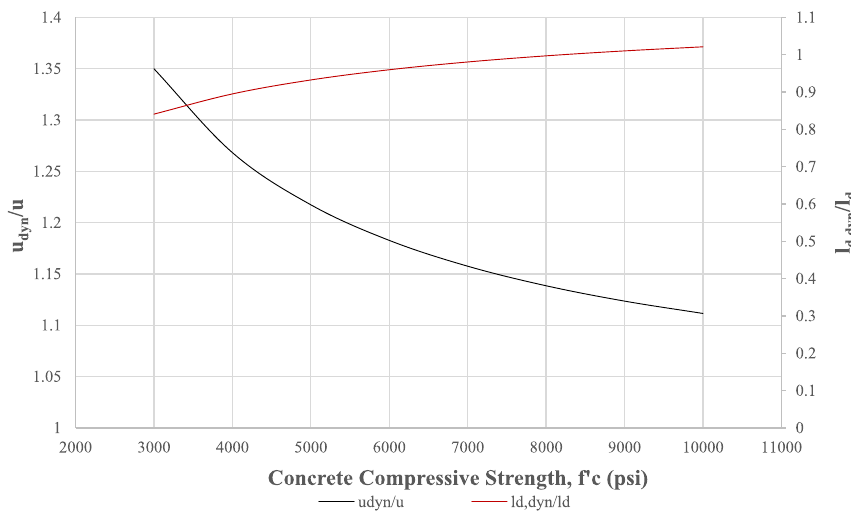
Fig. 10 Bond stresses and development length’s ratios at corresponding concrete compressive